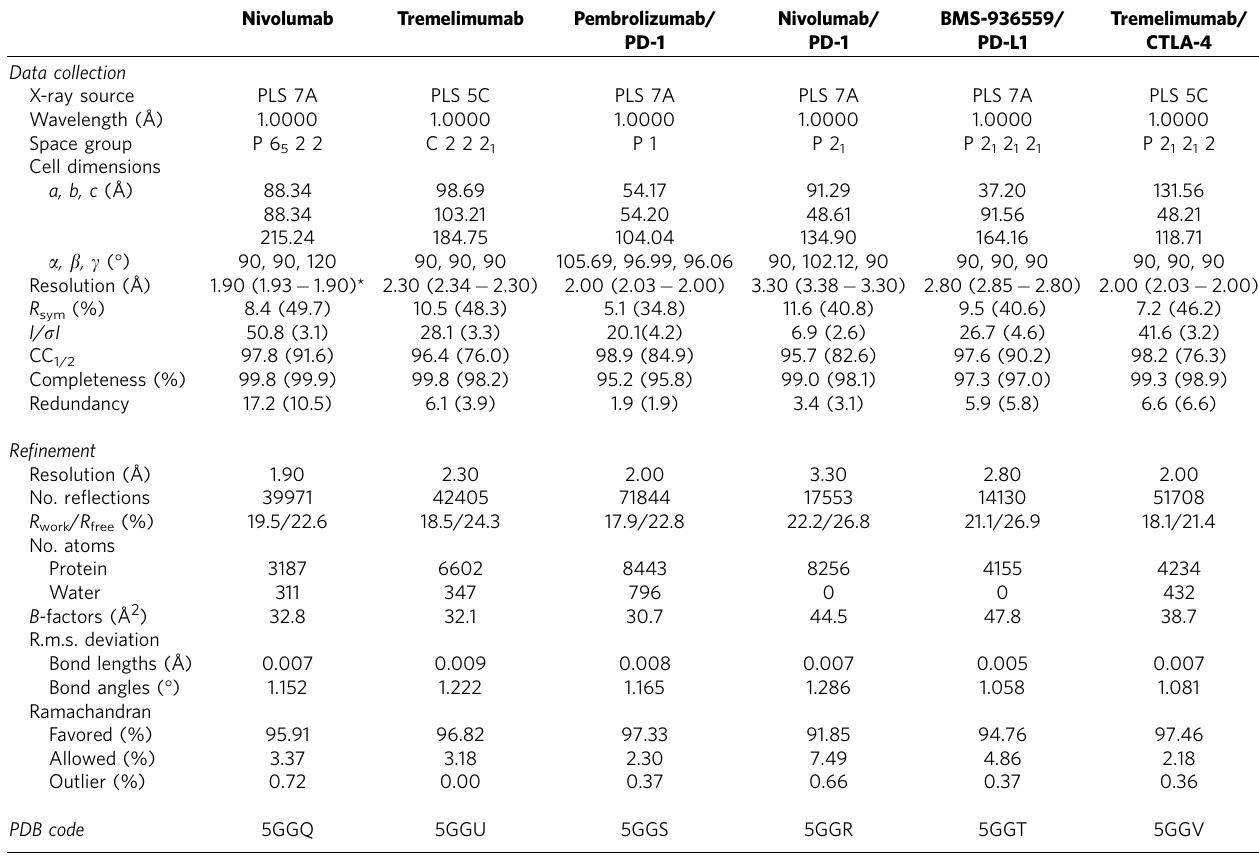
Table 1 | Data collection and refinement